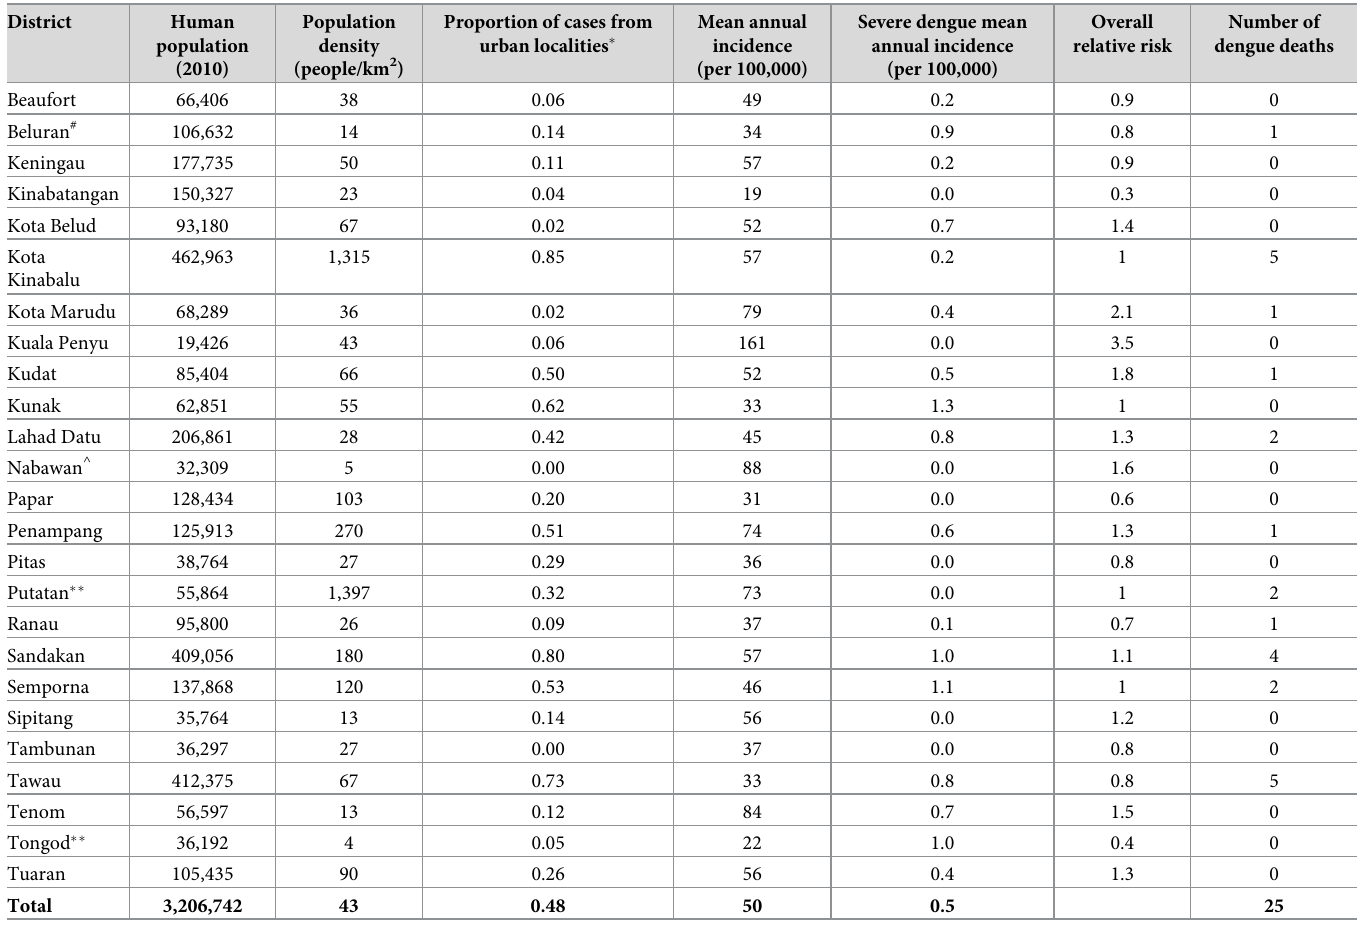
Table 1. Summary of population and dengue burden across Sabah,